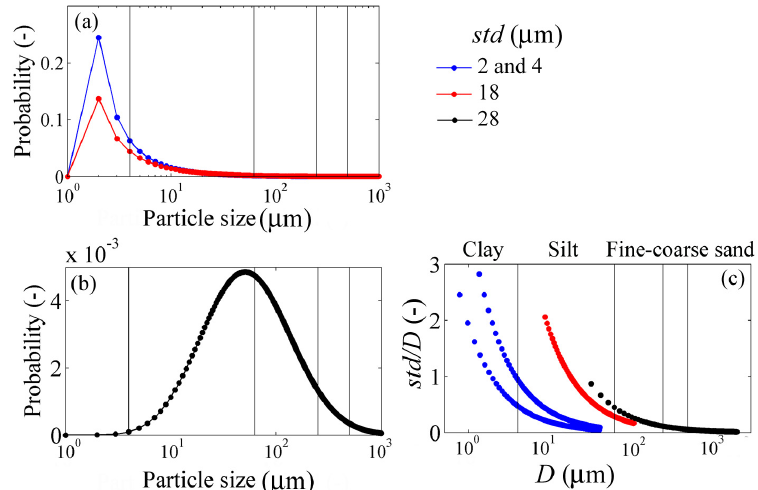
Figure 9. Generated lognormal number distributions ( i.e. , synthetic PSDs) for ( a ) clay-silt fraction and ( b ) sand fraction; ( c ) Particle mean sizes and corresponding standard deviation over mean size ratios for the synthetic PSDs.